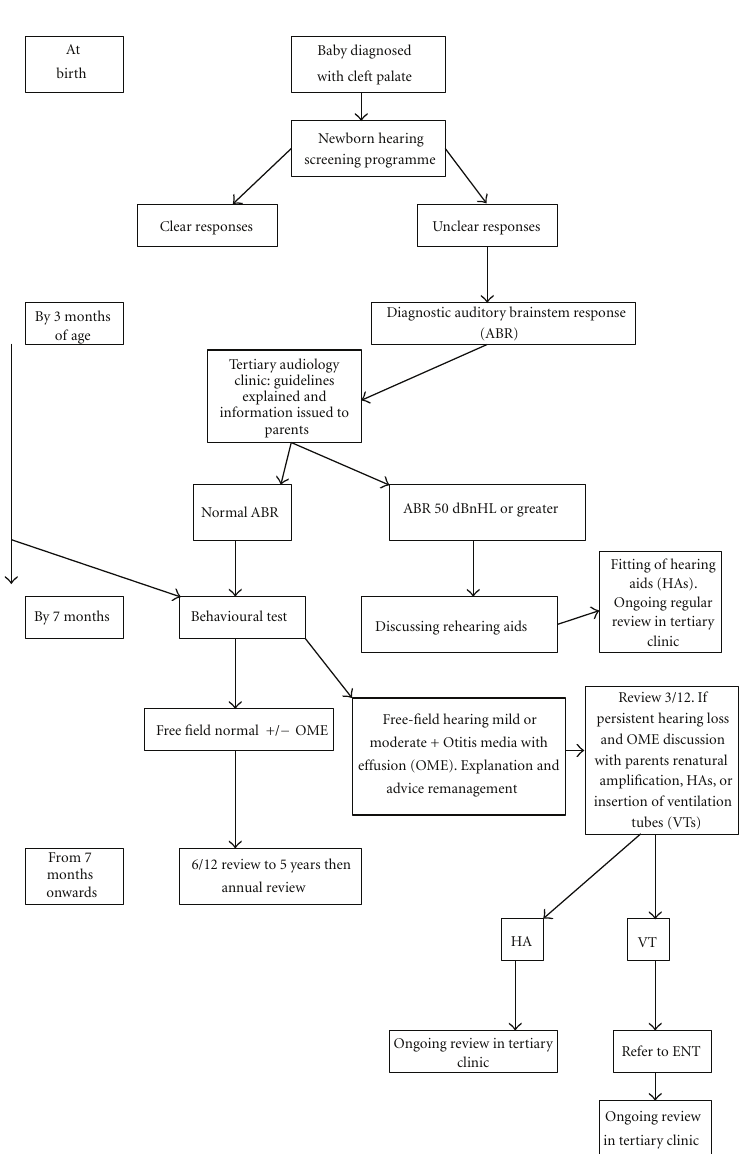
Figure 1: Audiological care pathway for children with cleft palate in the mersey